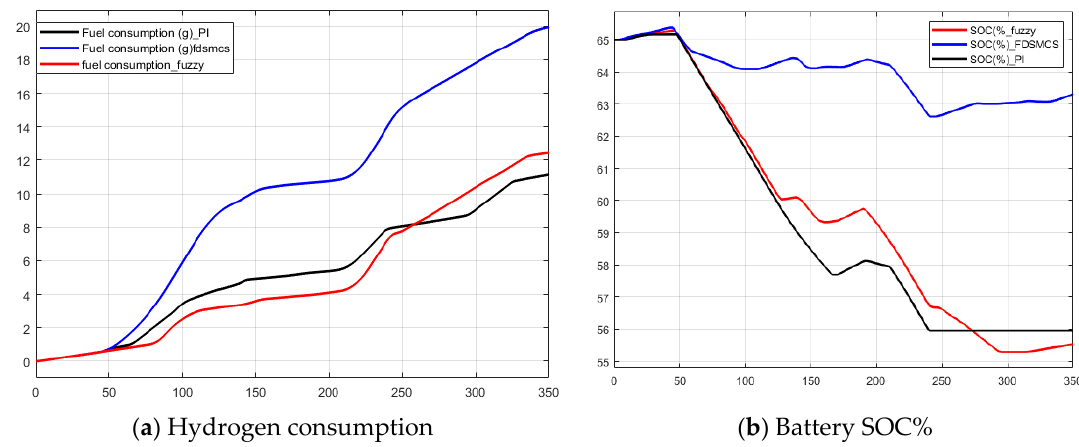
Figure 25. Comparison among considered control strategies ( a ) hydrogen consumption and ( b ) battery SOC%.